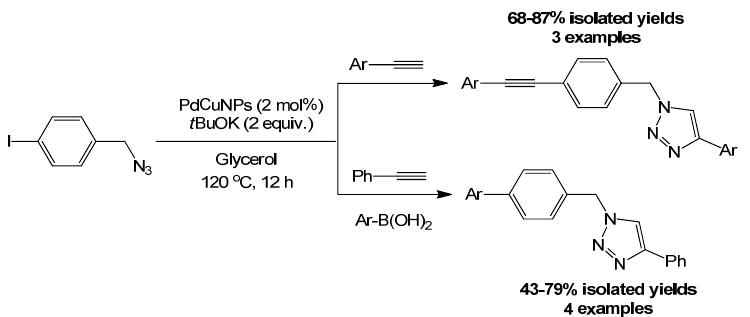
Scheme 53. Synthesis of functionalized 1,2,3-triazoles by one-pot tandem ACC/C − C cross-coupling reactions catalyzed by PdCu-BMNPs